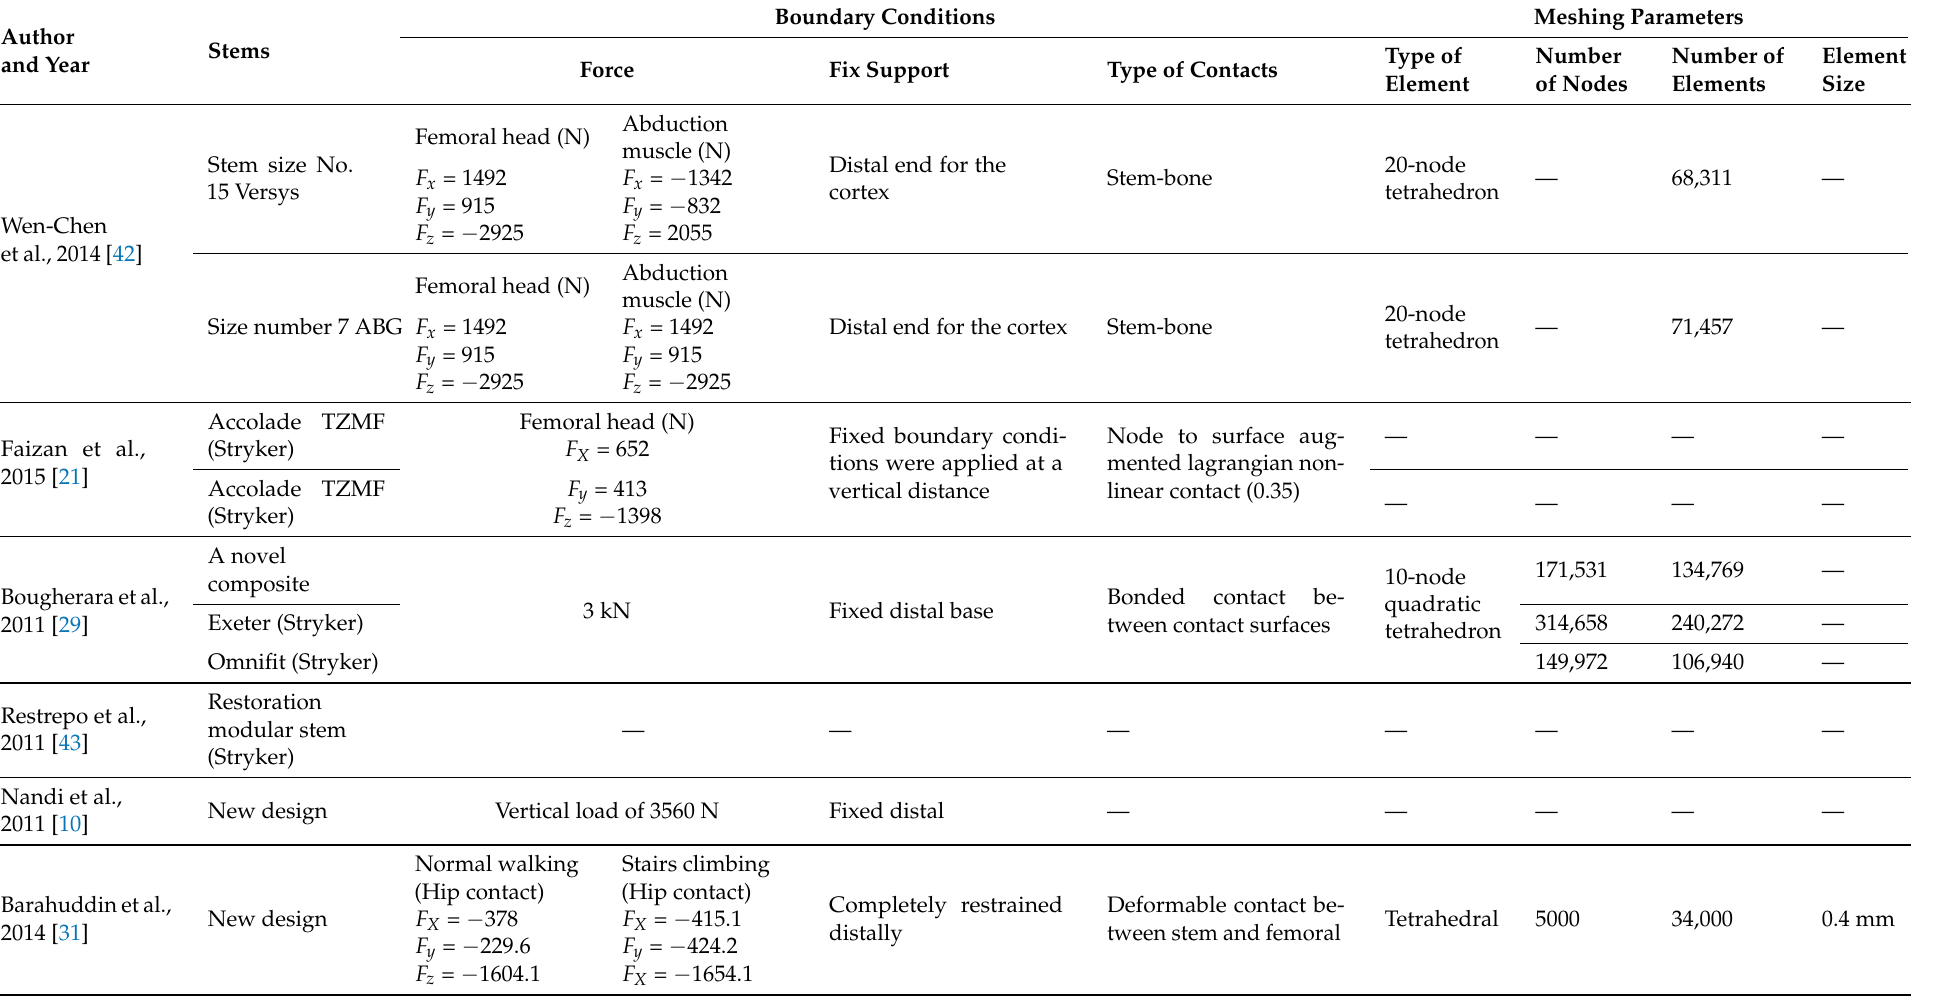
Table 1. Results from identified stems: boundary conditions and meshing